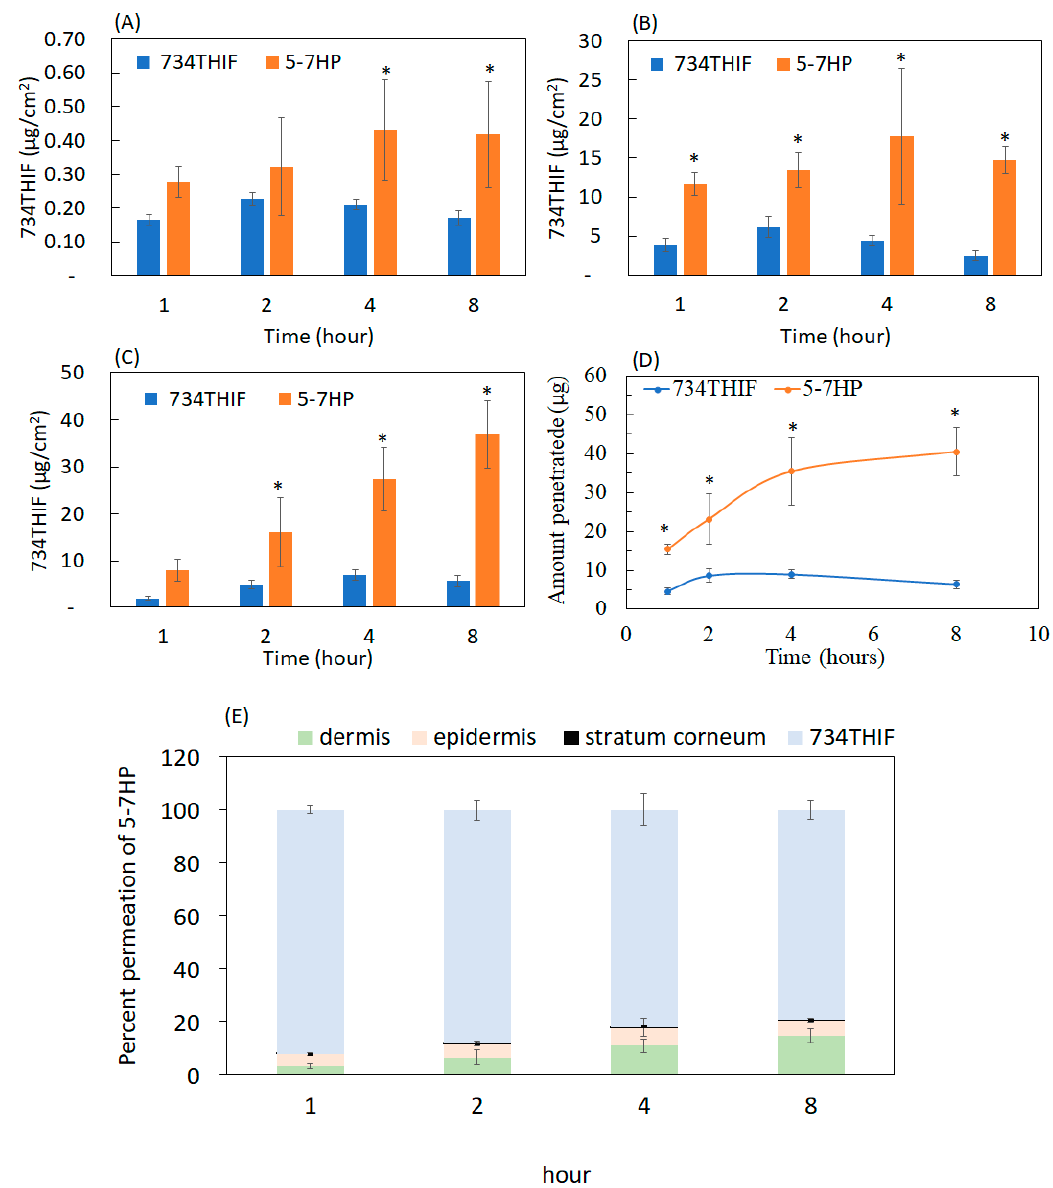
Figure 7. The contents of 734THIF delivered from 734THIF and 5-7HP to different skin layers: ( A ) stratum corneum, ( B ) epidermis, ( C ) and dermis. ( D ) 734THIF amount permeation in epidermis and dermis treated at different times. ( E ) Percent of 734THIF penetrated into different skin layer. Values are mean ± SD ( n = 6). * p < 0.05 compared with raw 734THIF. Table 4. Scavenging 50% DPPH free radicals (SC 50 ) concentration of 734THIF (in water and DMSO) and 5-7HP. Group SC 50 ( µ g / mL) 734THIF in H 2 O (734H) 19.03 ± 1.03 Values are mean ± SD ( n = 3). a NE indicated no effect.